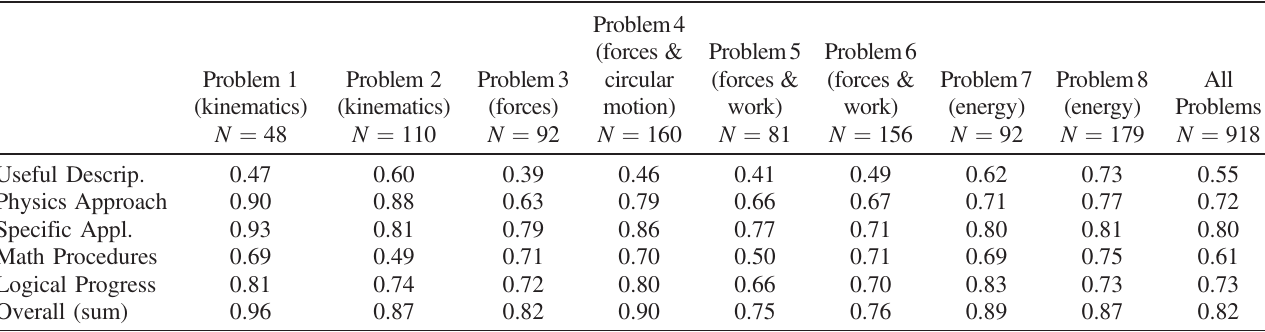
TABLE III. Correlations between rubric scores (both overall and for each individual category) and TA grades for each of eight midterm problems ( N ¼ 918 solutions). The overall (sum) score adds together all of the category scores with equal weight as described in the text and then calculates a correlation with the TA